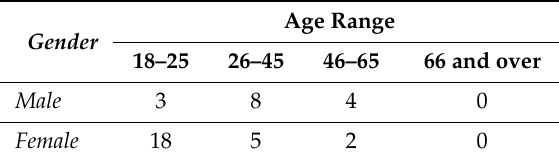
Table 2. Questionnaire respondents demographics.